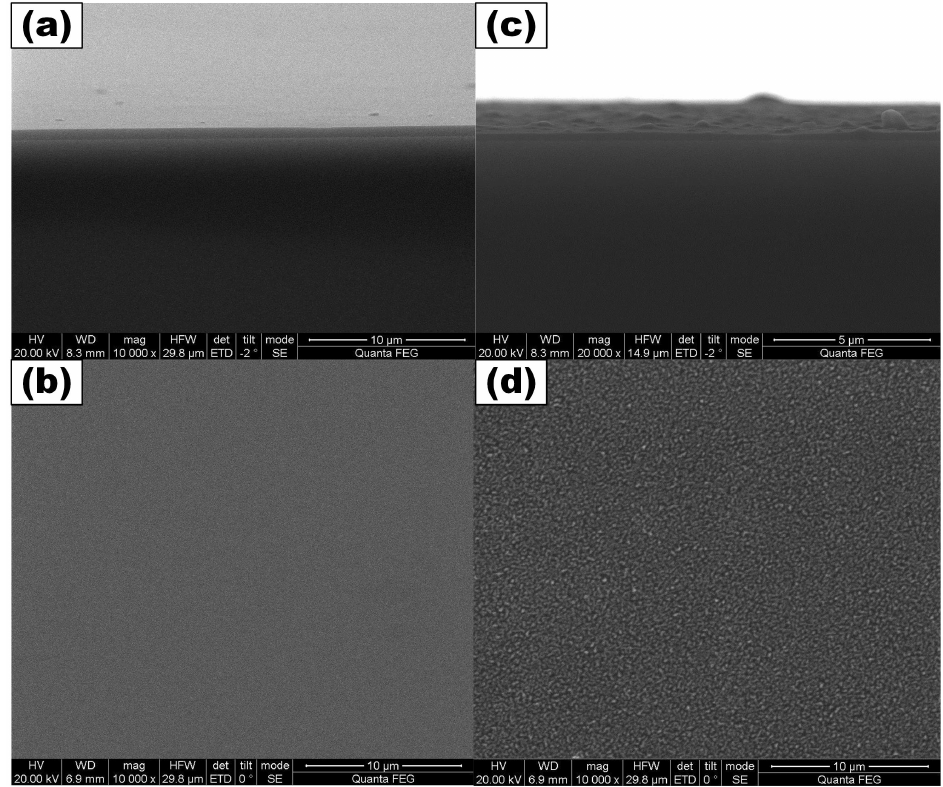
Figure 2. The basic procedure of texture feature code calculation of a palmprint image. Given a pixel Figure 2. SEM images of the composite films containing 5 wt. % azobenzene and heated at ( a , b ) of a palmprint image, we first calculate the pixel distance between the pixel and its eight neighboring 50 ◦ C and ( c , d ) 200 ◦ points. Then, we select the two neighboring points with the two maximum pixel distances and encode the position of them into the texture feature code.